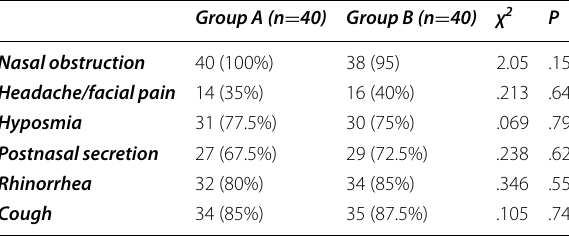
Table 2 Complain distribution between the two studied groups